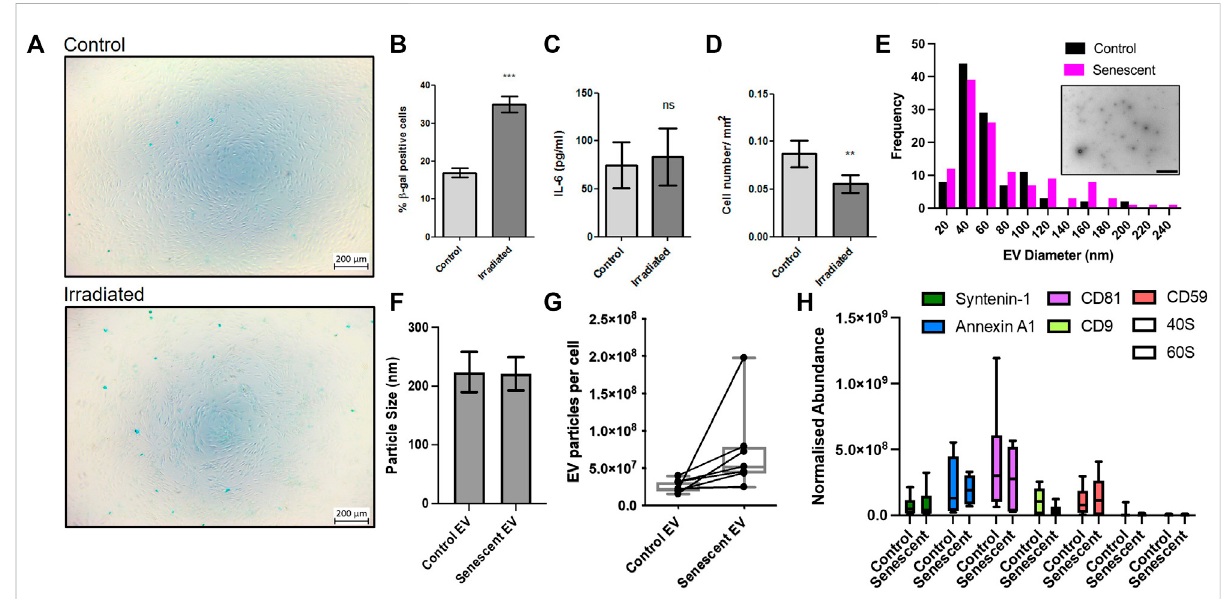
FIGURE 1 Induction of synovial fi broblast senescence and EV isolation. (A,B) β -galactosidase staining con fi rmed senescence 21 days post irradiation of primary human synovial fi broblasts (n=6). SeeSupplementary Figure 1 stainingcon fi rmingno morphologicaldifferences. (C) Fibroblast conditioned mediaanalysedforchangesinIL-6secretionbyELISA( n =6). (D) Totalcellcountsofirradiatedandcontrol fi broblasts( n =6). (E) RepresentativeTEM micrographofisolatedextracellularvesicles(embedded,scalebaer1,000 nm)andsizedistribution. (F – H) CharacterizationofEVsize,particular number using nanoparticle tracking and abundance of EV transmembrane and EV cytosolic proteins following EV isolation. Plotted are the mean ± SEM. ** = p < 0.01; *** = p < 0.001, by paired two-tailed t